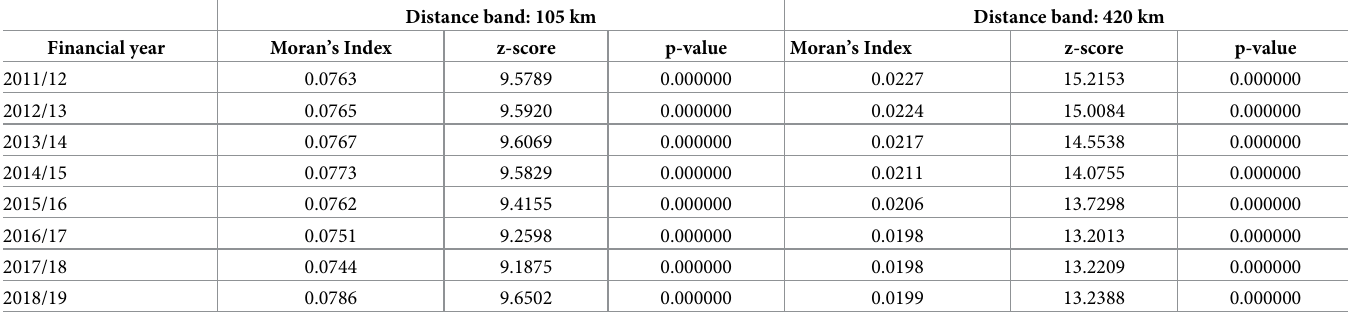
Table 5. Global Moran’s I